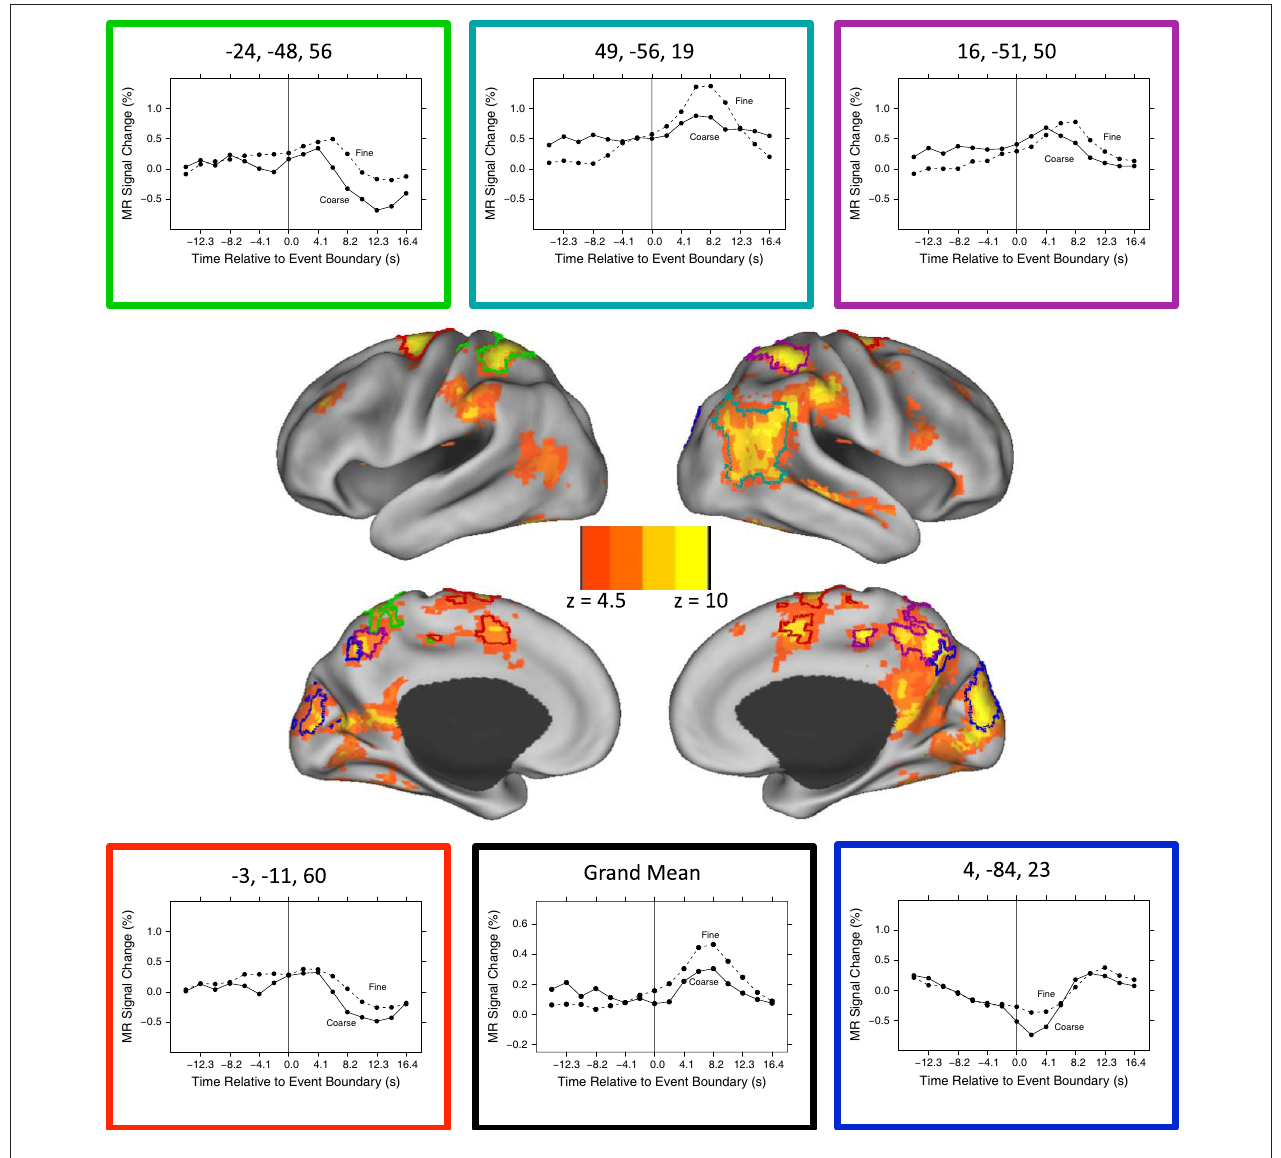
Essen et al., 2001) and the PALS cortical surface atlas (Van Essen, 2005). The five regions with the highest peak z values (see Table 3 ) have been outlined in different colors, and the timecourses of their responses are depicted in the surrounding line graphs. The lower middle line graph plots the grand mean response for all the regions in Table 3